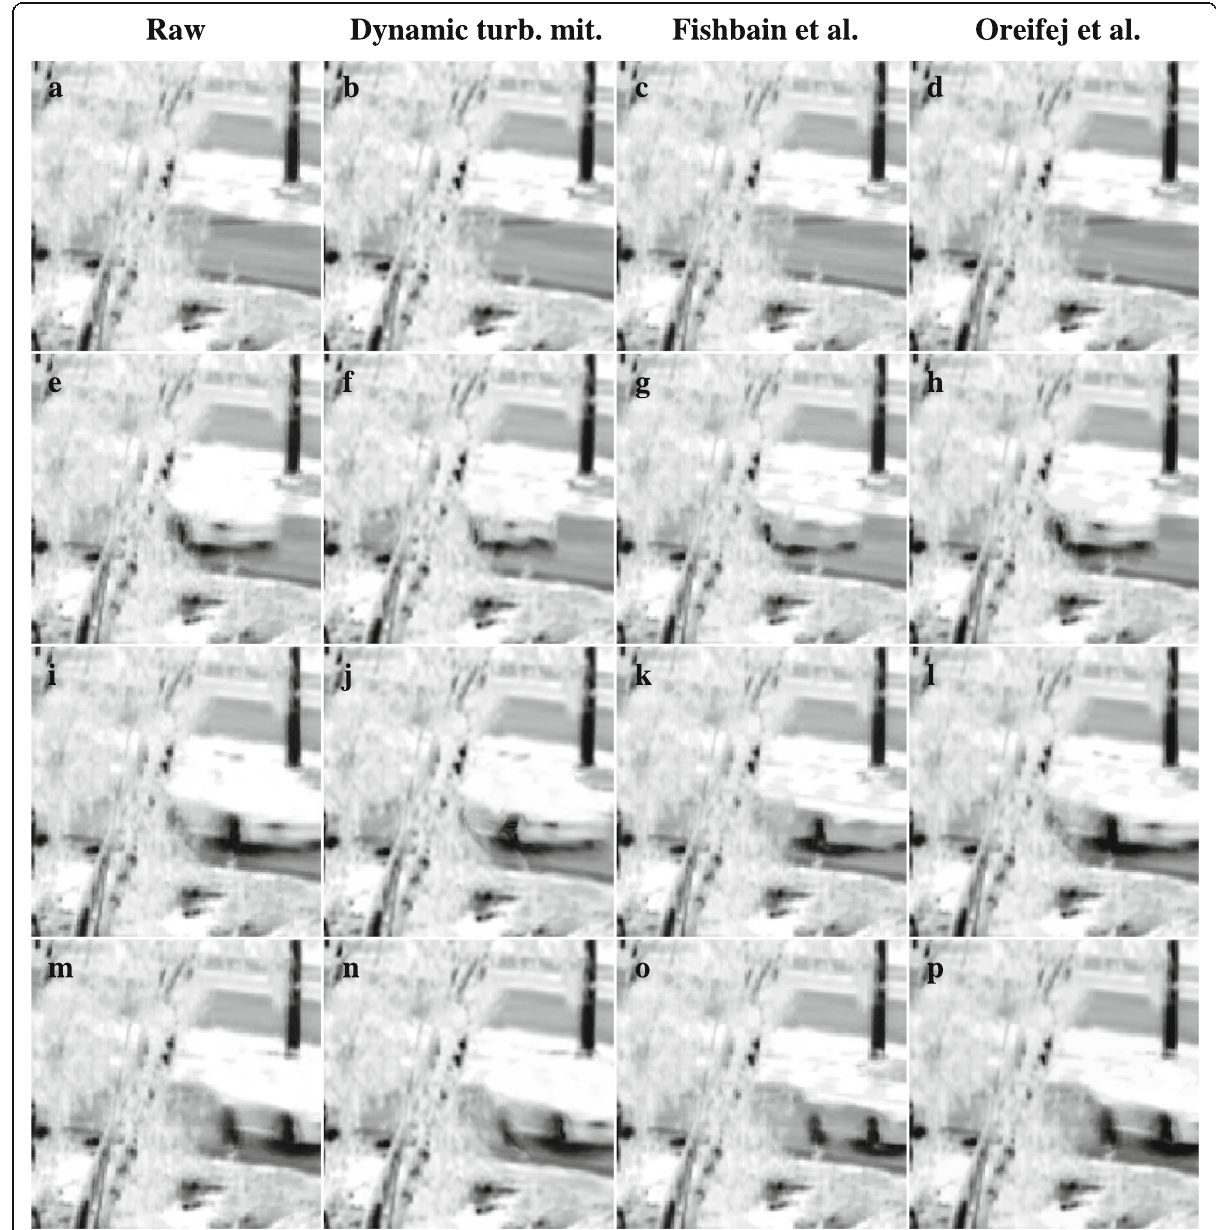
Fig. 16 Comparison of turbulence mitigation results on a thermal infrared recording of a car appearing from behind a set of trees. The different rows show different frames in the sequence. Columns show respectively from left to right: raw frames ( a , e , i , m ), results obtained with our method ( b , f , j , n ), results obtained by Fishbain et al. [9] ( c , g , k , o ), and results obtained with the method by Oreifej et al. [13] ( d , h , l , p